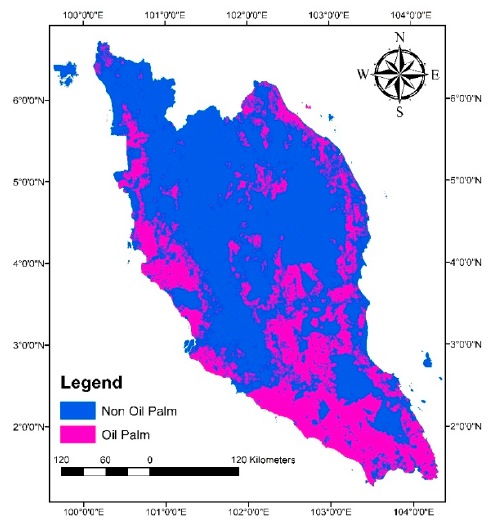
( e ) Final map showing the areas planted with oil palm. Figure 5. Oil palm areas delineation in Peninsular Malaysia using ALOS PALSAR, Sentinel 1C, and Landsat Thematic Mapper images.